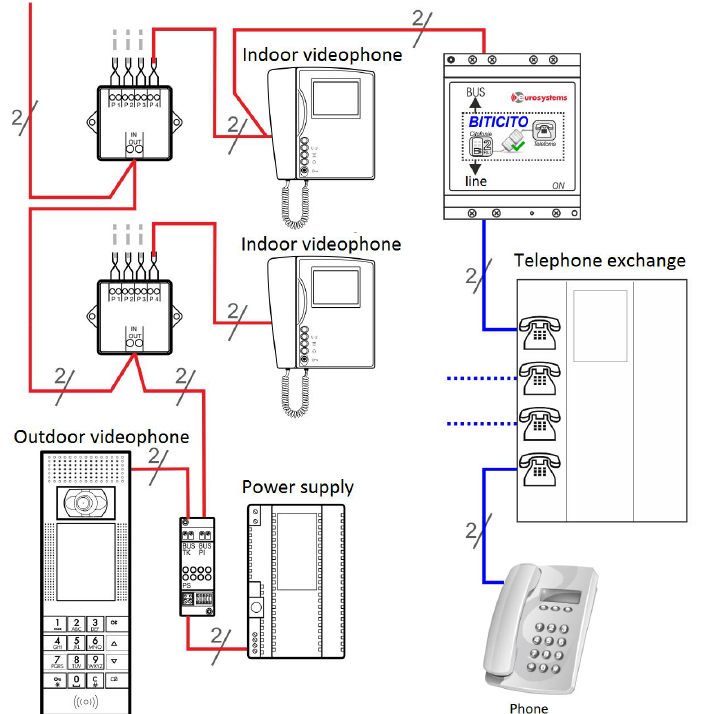
Figure 23. Description of the videophone